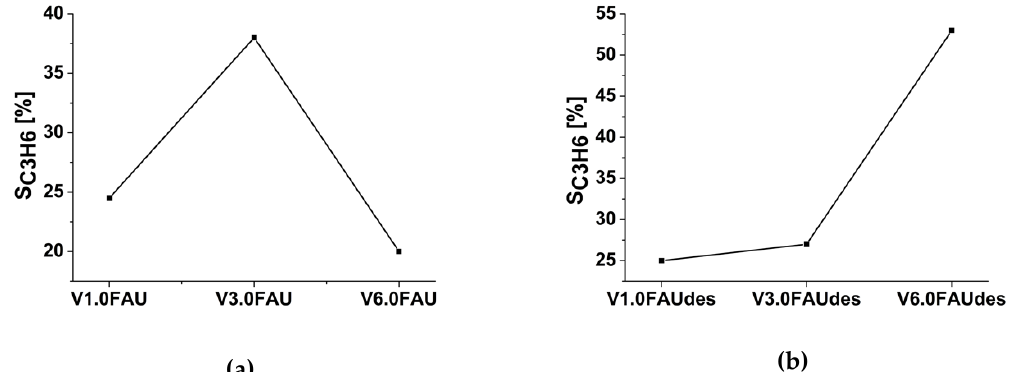
Figure 9. Selectivity to propene at a constant conversion equal to 10% (±2%) at 450 °C for the V x FAU (a) and at constant conversion equal to 5% at 450 °C for the V x FAUdes (b) series.